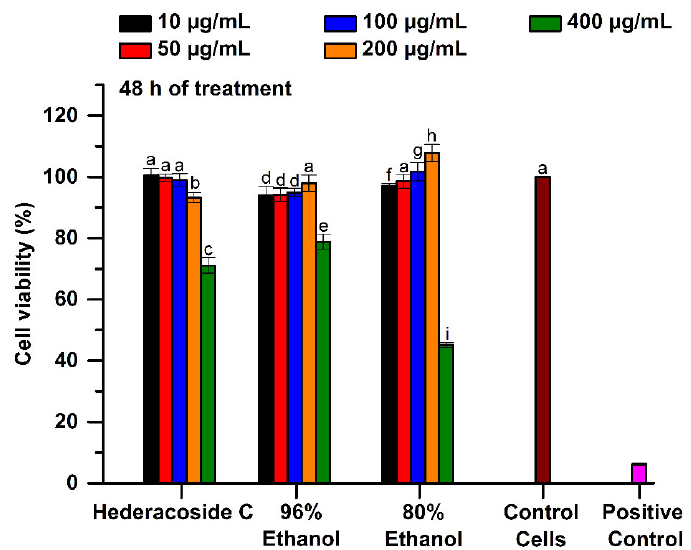
Figure 7. Cell viability of L929 fibroblasts cultured in the presence of 96% and 80% ethanolic Hedera helix extracts and hederacoside C as saponin standard, assessed by MTT assay, at 48 h of treatment. Untreated cells in the culture medium and the cells cultivated in the presence of 0.003% H 2 O 2 were used as controls. Different letters (a–i) shows the significant difference between samples (ANOVA, p < 0.05).